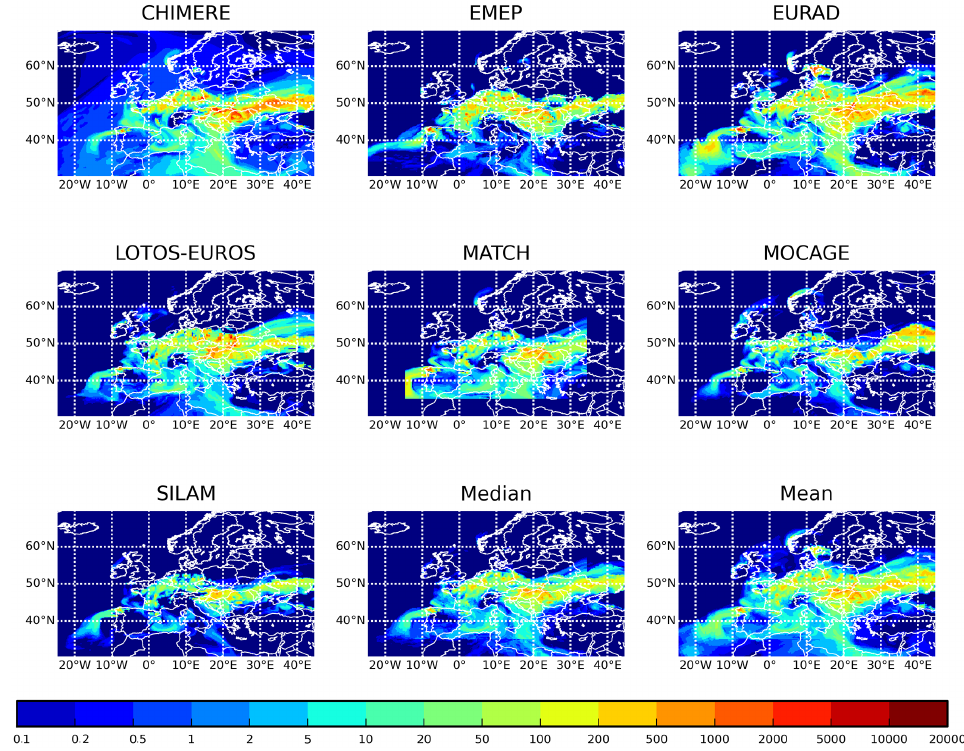
Figure 4. Example of hourly birch pollen concentration maps: 12:00 UTC, 20 April 2013 (pollenm − 3